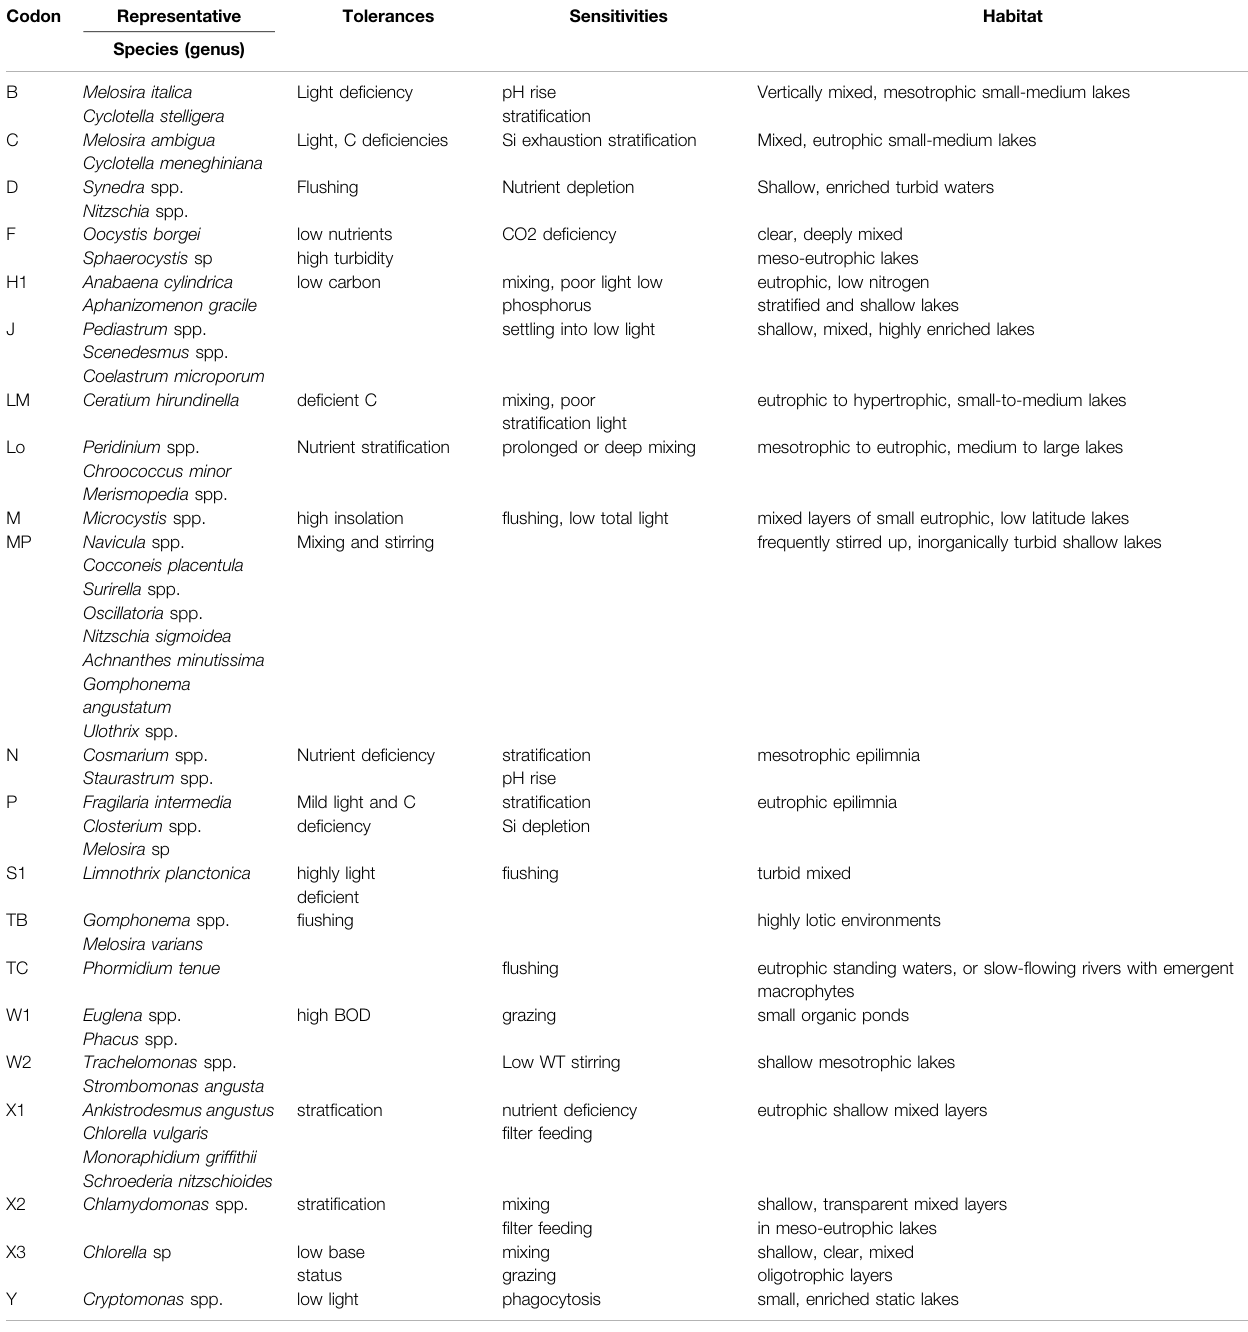
TABLE 5 | Main identi fi cation characteristics and representative species of Xinmiao Lake functional group during the survey